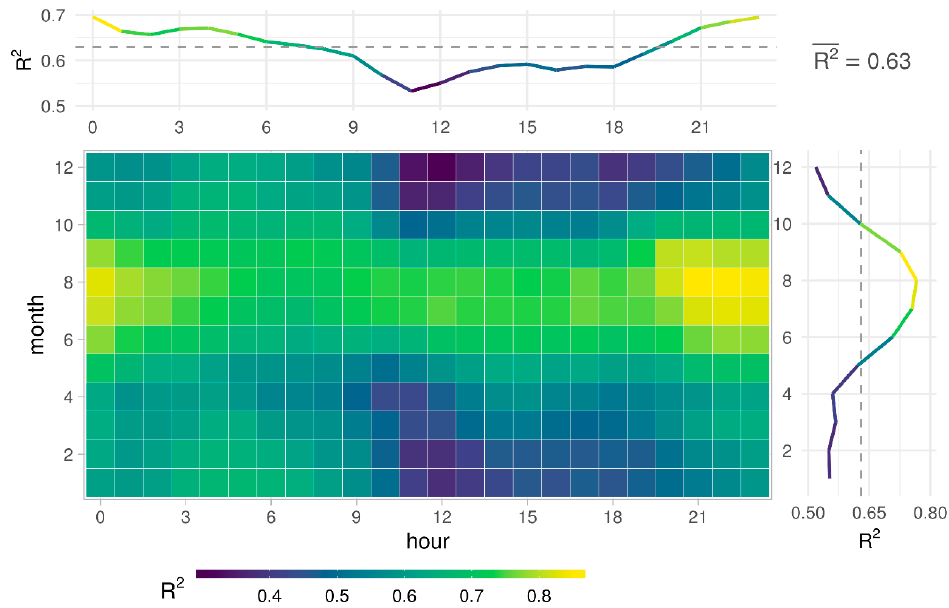
Figure 16. The 5-fold cross-validated R 2 of the Stage 3 GAM model across 2004–2017, averaged by hour (upper panel) and month (right panel).